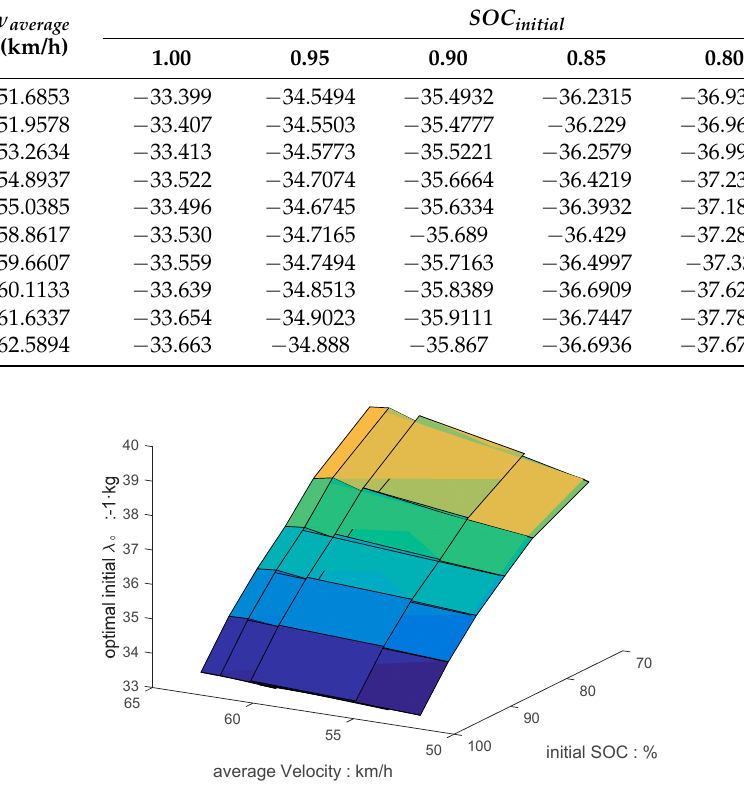
Figure 9. λ 0 map solving by equal distance process.